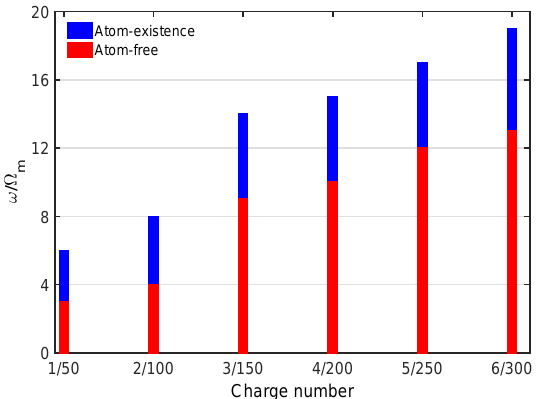
Figure 4. The cutoff order of the higher-order sidebands varied with charge number n under two circumstances: the atom-existence case (blue columns) and the atom-free case (red columns). The other parameters are the same as those in Figure